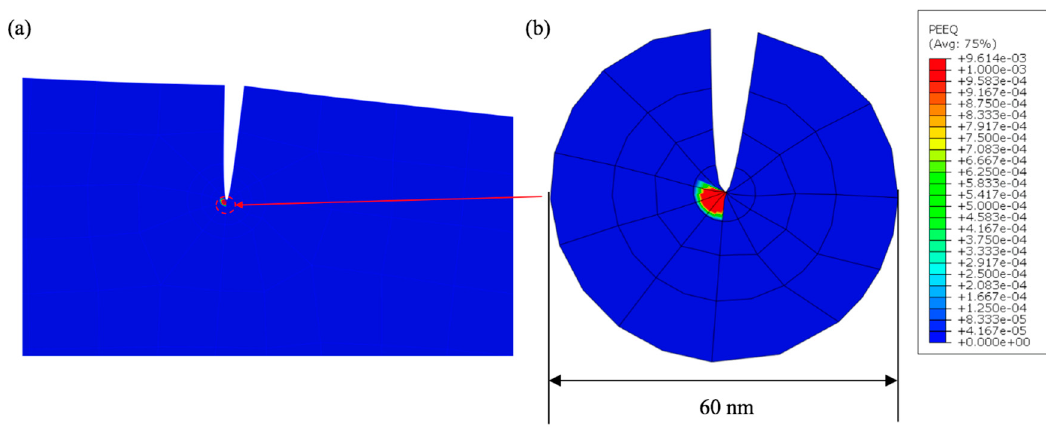
Figure 8. Non-linear fracture mechanical mode (NLEFM) analysis results of micro-cantilever beam for L = 4 µm: ( a ) Far-field view, ( b ) localized view near crack-tip showing equivalent plastic strain contour.